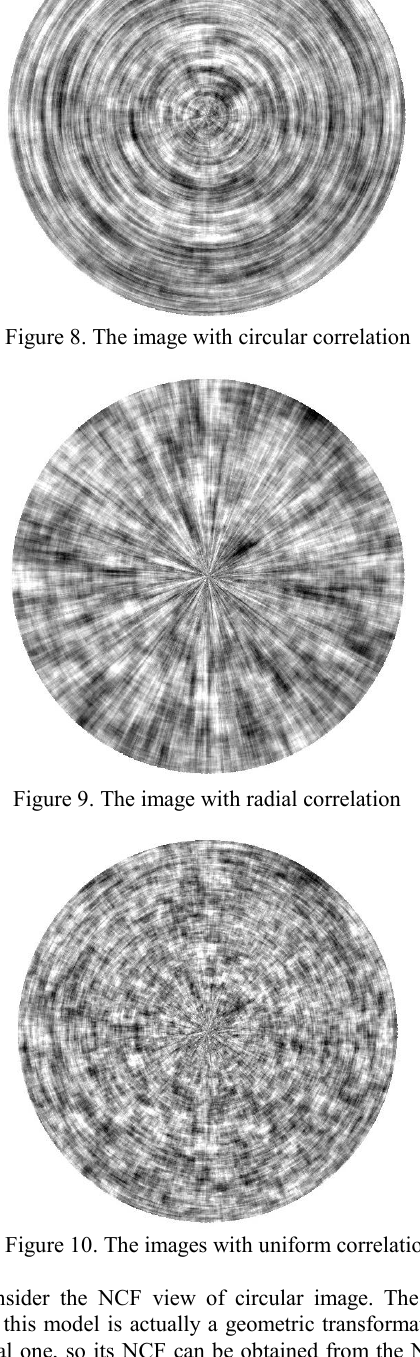
Figure 7. Grids on a circle: a) circular, b) spiral